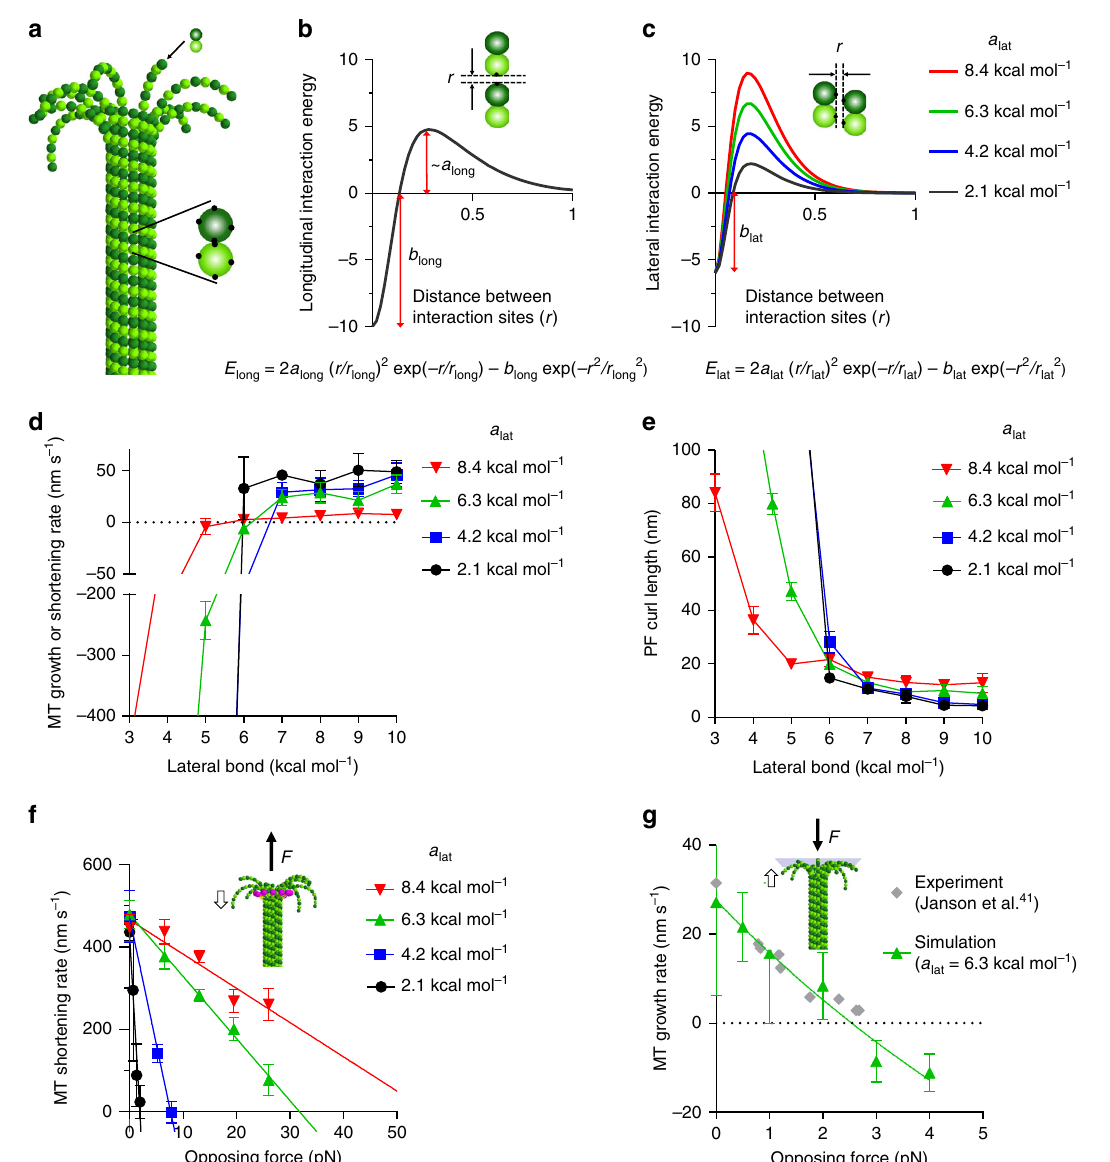
Fig. 2 Role of lateral tubulin activation energy for MT dynamics and force generation. a Visualization of an MT, β - and α -tubulins depicted as in Fig. 1. Each tubulin monomer has two lateral and two longitudinal interaction sites (black dots). b Energy of longitudinal interaction between tubulin monomers as a function of distance between the interaction sites. Formula below describes the shape of longitudinal tubulin energy potentials. c A set of energy curves, describing lateral tubulin − tubulin interactions as a function of distance with different lateral activation energies ( a lat ). Strength of the lateral bond, b lat , equals 6 kcal mol − 1 in this example. d Dependence of MT growth or shortening rate on the lateral bond strength, b lat , for different lateral barrier parameters, a lat . Numbers less than zero imply shortening. e Dependence of PF curl length on the strength of the lateral bond, b lat , graphed for several lateral activation energies, a lat . f Dependence of MT shortening rate on opposing force in simulations. The strength of the lateral bonds between the tubulins ( b lat ) was set to be weak, representing tubulins in the GDP state. Speci fi cally, with each activation barrier height ( a lat ), b lat was selected to enable shortening at ~400nm s − 1 . See Source Data fi le for a full list of parameter values in all simulations. g Dependence of MT growth rate on opposing force in simulation and experiment. Tubulins were con fi gured to have strong lateral bonds, b lat = 8 kcal mol − 1 , to represent the GTP-state of tubulins. No GTP hydrolysis was allowed. Data points, describing simulation results in all graphs in this fi gure, represent mean ± s.d. based on 3 – 6 repeats of each simulation. Source data are provided as a Source Data fi